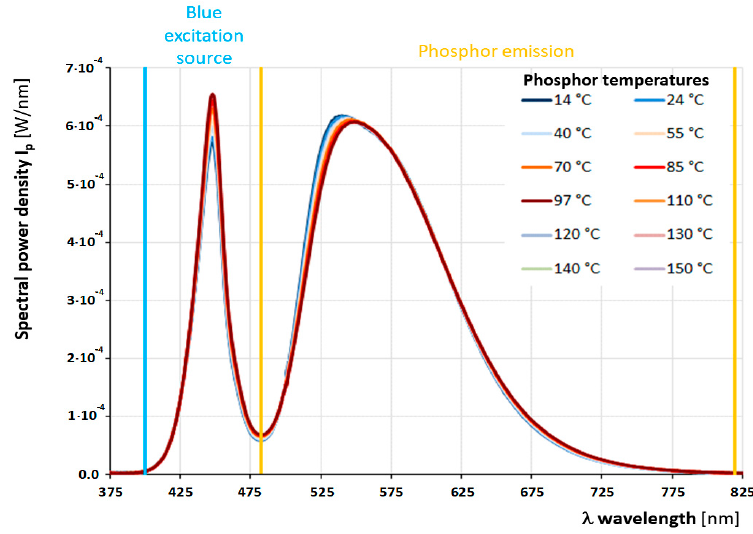
Figure 8. Temperature-dependent spectral power distribution (SPD) of a custom-made remote phosphor sample.